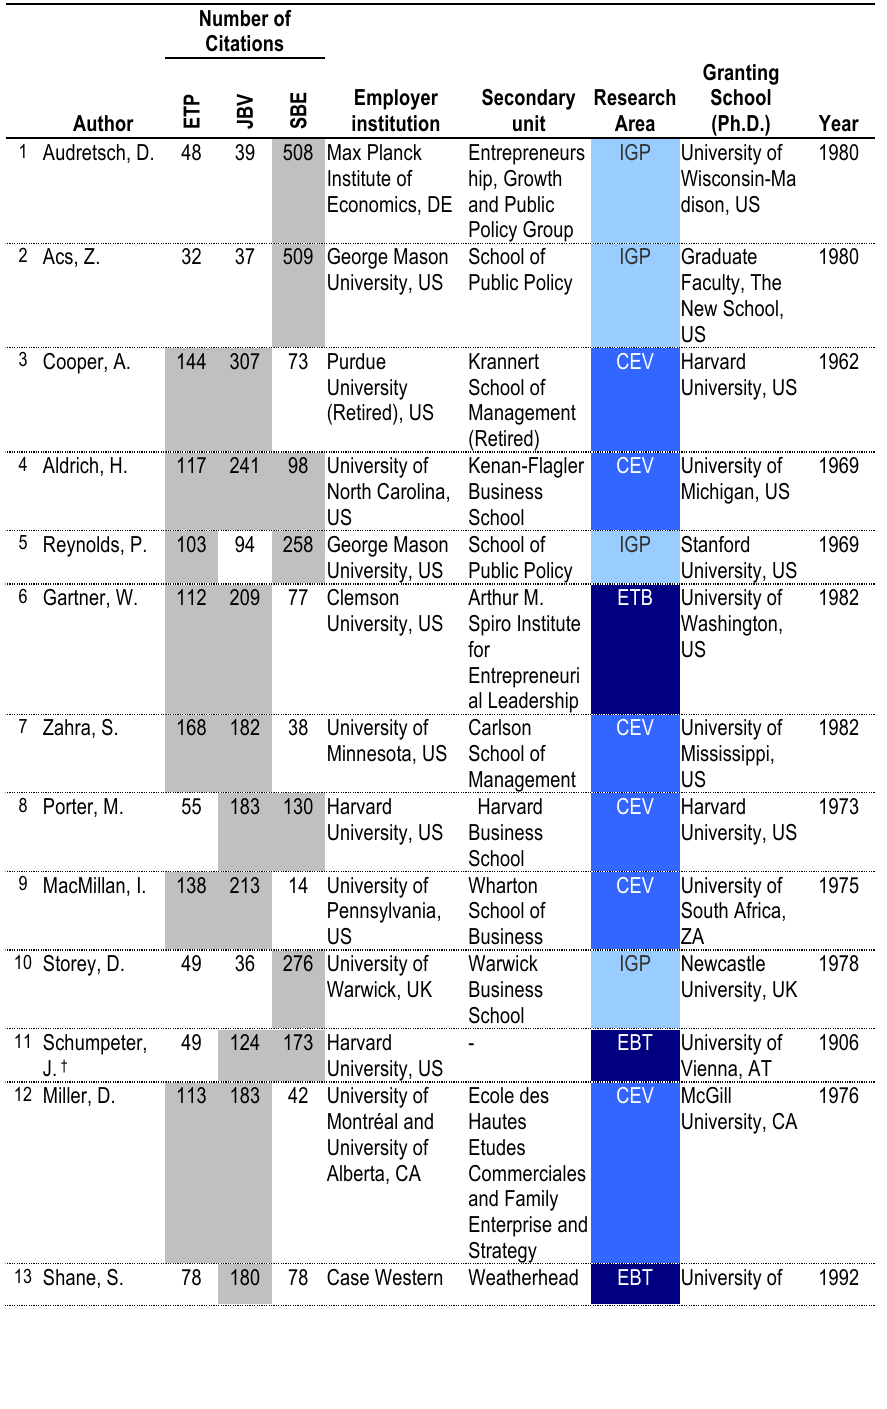
Table 7: Information on the professional affiliation, educational background and research area of the 47 most cited authors